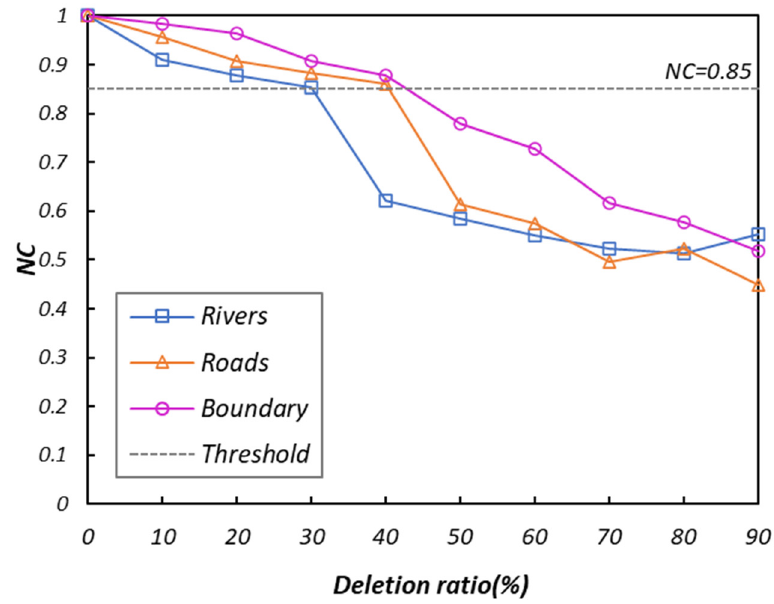
Figure 11. The results of deletion attacks.